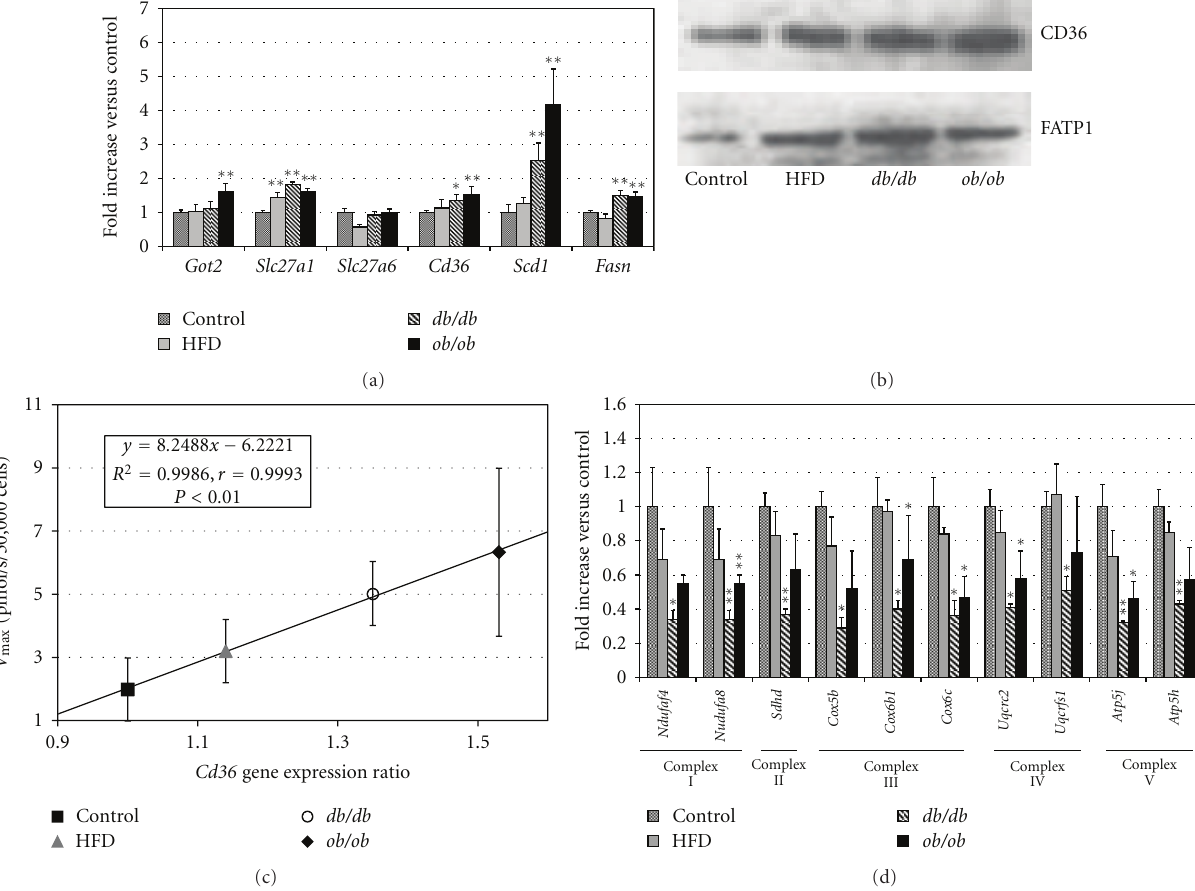
Figure 5: (a) Cardiac gene expression ratios for cardiac LCFA transporters ( Got2, Slc27a1, Slc27a6, and Cd36) and for two enzymes of LCFA synthesis, stearoyl CoA desaturase-1 ( Scd1 ), and fatty acid synthase ( Fasn ). Fasn and Scd1 were significantly upregulated in ob/ob and db/db mice. (b) Representative Western blots of expression of CD36 and FATP1 in control, HFD, db/db, and ob/ob mice. (c) V max for [ 3 H]-oleic acid uptake in cardiomyocytes is significantly correlated with the Cd36 gene expression ratio in all obesity groups. (d) Cardiac expression ratios of 10 oxidative phosphorylation genes. Complex I: NADH dehydrogenase ( Ndufaf4, Ndufa8) ; complex II: fumarate reductase (Sdhd) ; complex III: cytochrome c reductase (Cox5b, Cox6b1, and Cox6c) ; complex IV: cytochrome c oxidase (Uqcrc2, Uqcrfs1); Complex V: F-type ATPase (Atp5j, Atp5h ) were all downregulated in all obesity groups. Error bars indicate ± 1 SE. ∗ P < 0 . 05, ∗∗ P < 0 . 01 compared with the control